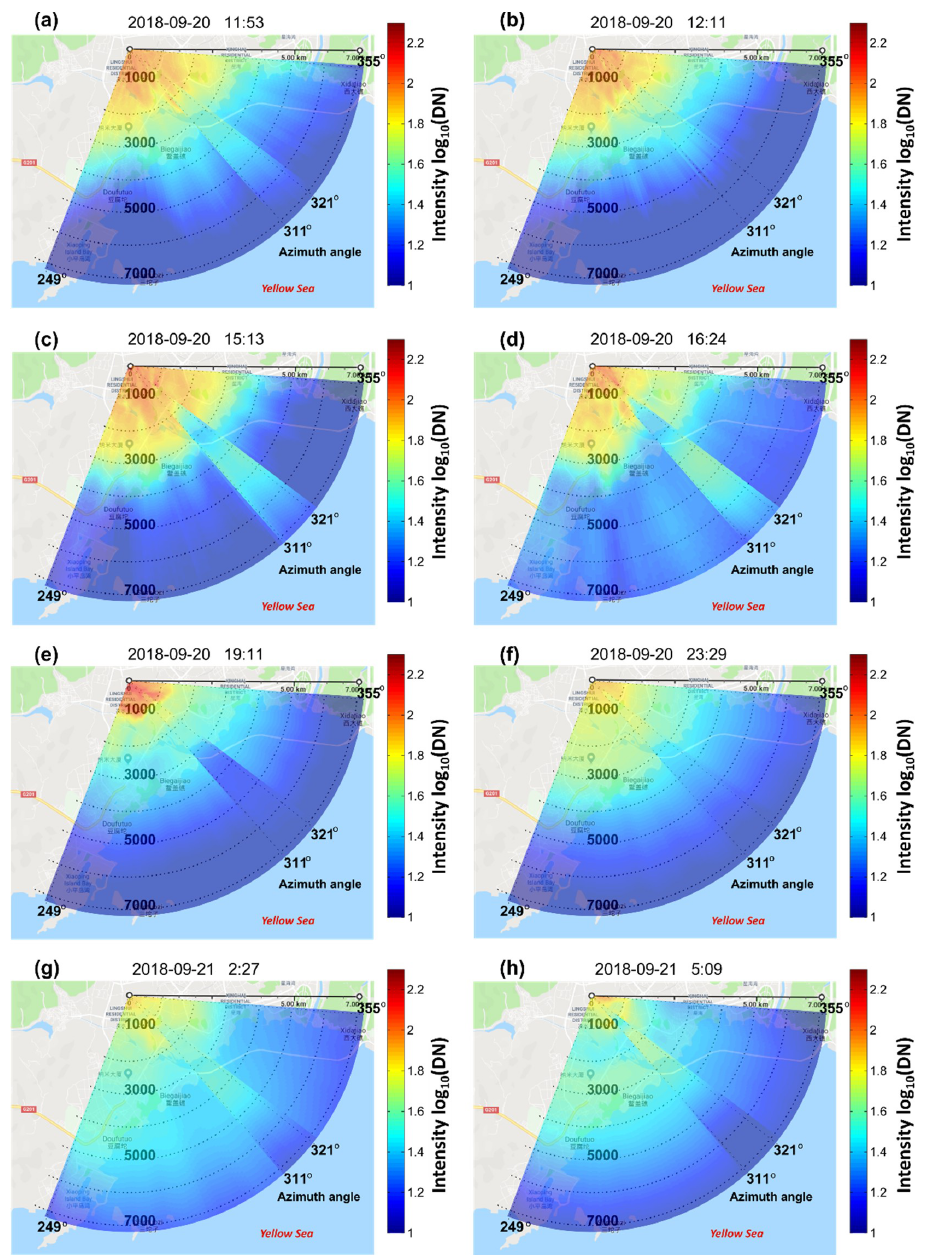
Figure 6. Horizontal scanning map of the received signal intensity measured at ( a ) 11:53, 2018-09-20, ( b ) 12:11, 2018-09-20, ( c ) 15:13, 2018-09-20, ( d ) 16:24 2018-09-20, ( e ) 19:11 2018-09-20, ( f ) 01:22, 2018-09-20, ( g ) 02:27, 2018-09-21, and ( h ) 05:09, 2018-09-21. Location of the lidar system: 38 ◦ 53 (cid:48) 00.7”N, 121 ◦ 31 (cid:48) 37.2”E. The local times indicated in the sub figures are 8 h ahead of the Universal Coordinated Time (UTC). DN means digital number of the pixel